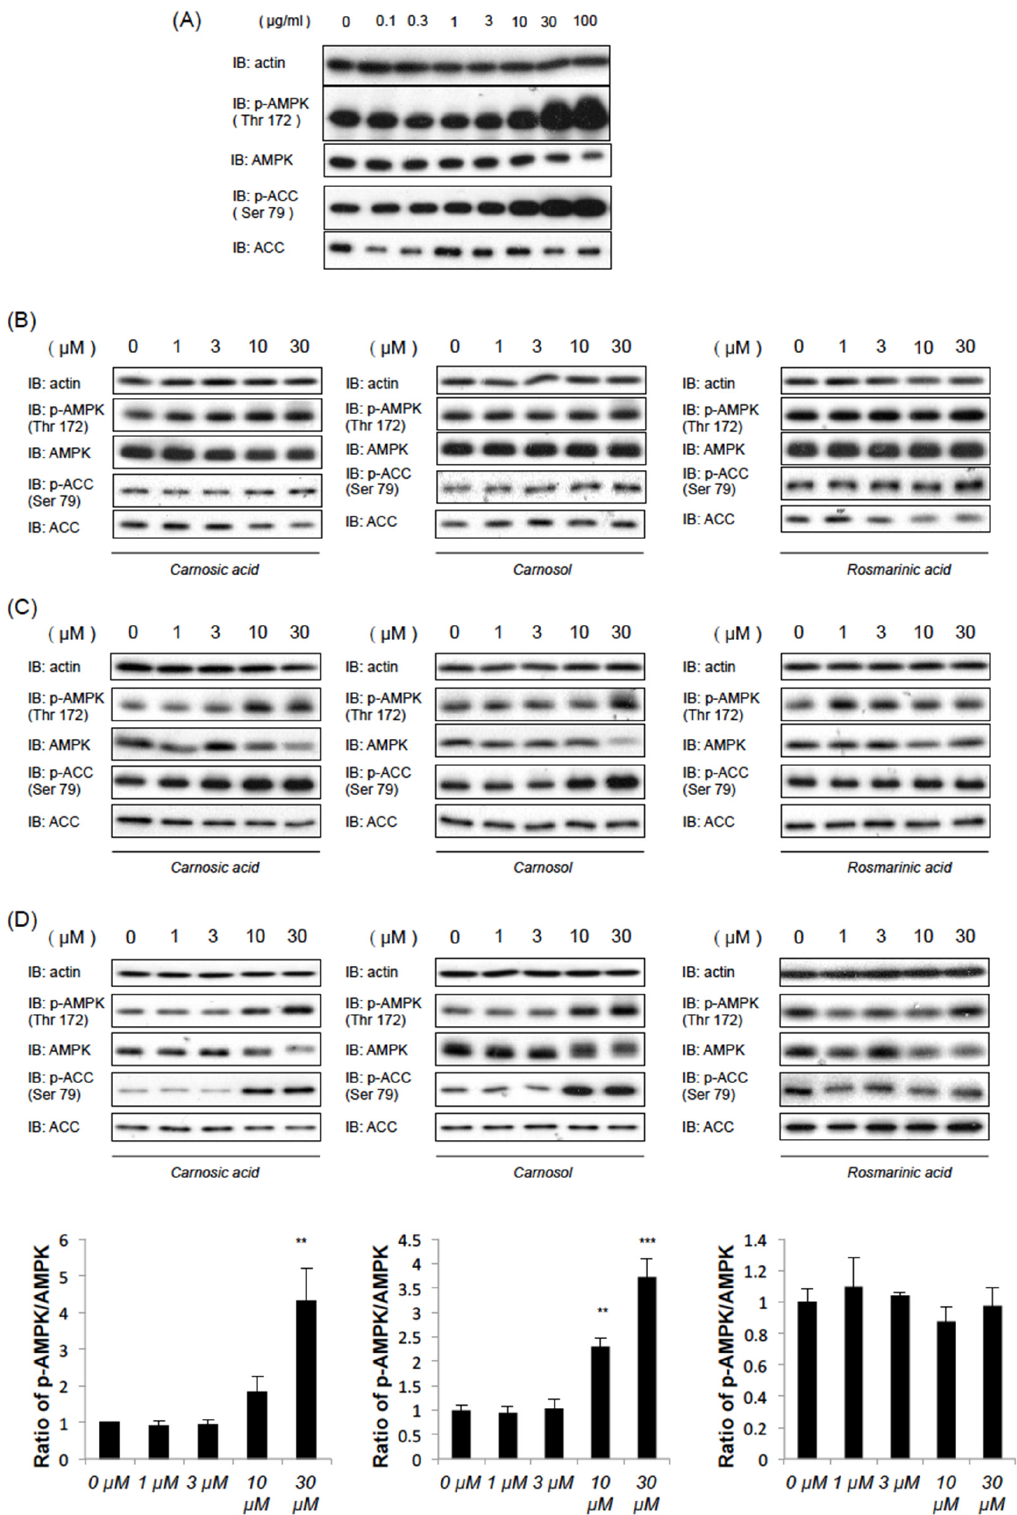
Figure 1. Carnosic acid (CA) and carnosol (CL), but not rosmarinic acid (RA), dose-dependently activate AMP-depenpent kinase (AMPK). After serum starvation for 3 h, the cells were treated with each compound at the indicated concentrations for 1 h. ( A ) The effects of rosemary extract on C2C12 myotubes. ( B – D ) The effects of CA, CL and RA in C2C12 myotubes ( B ), HEK-293T ( C ) or HepG2 cells ( D ). Relative band intensities (p-AMPK/AMPK) are also shown in Figure 1D. (**: p < 0.01, ***: p < 0.001).